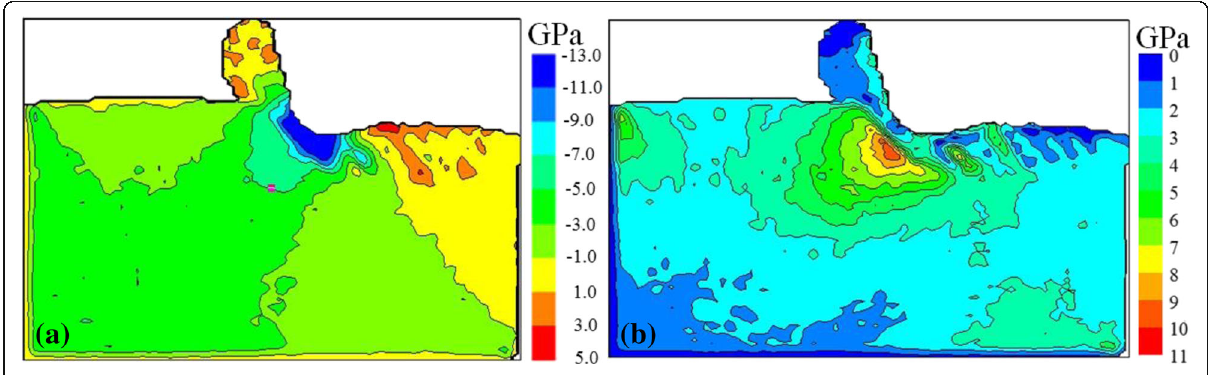
Fig. 4 a Hydrostatic pressure and b the maximum shear stress in